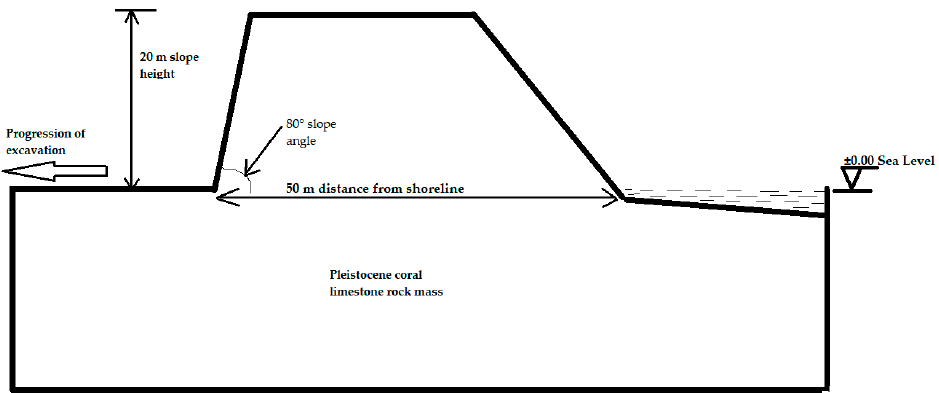
Figure 4. The quarry environment.